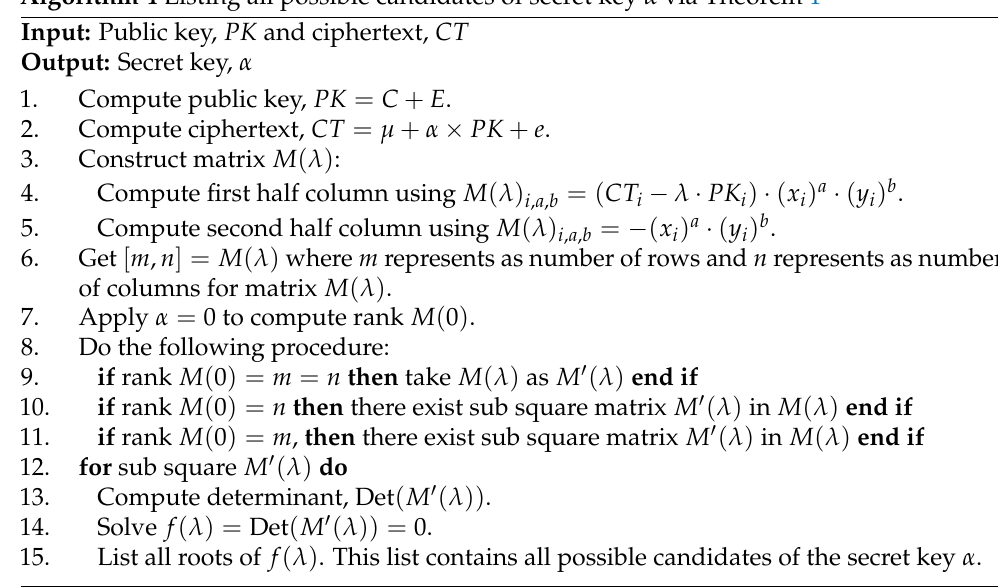
Algorithm 4 Listing all possible candidates of secret key α via Theorem